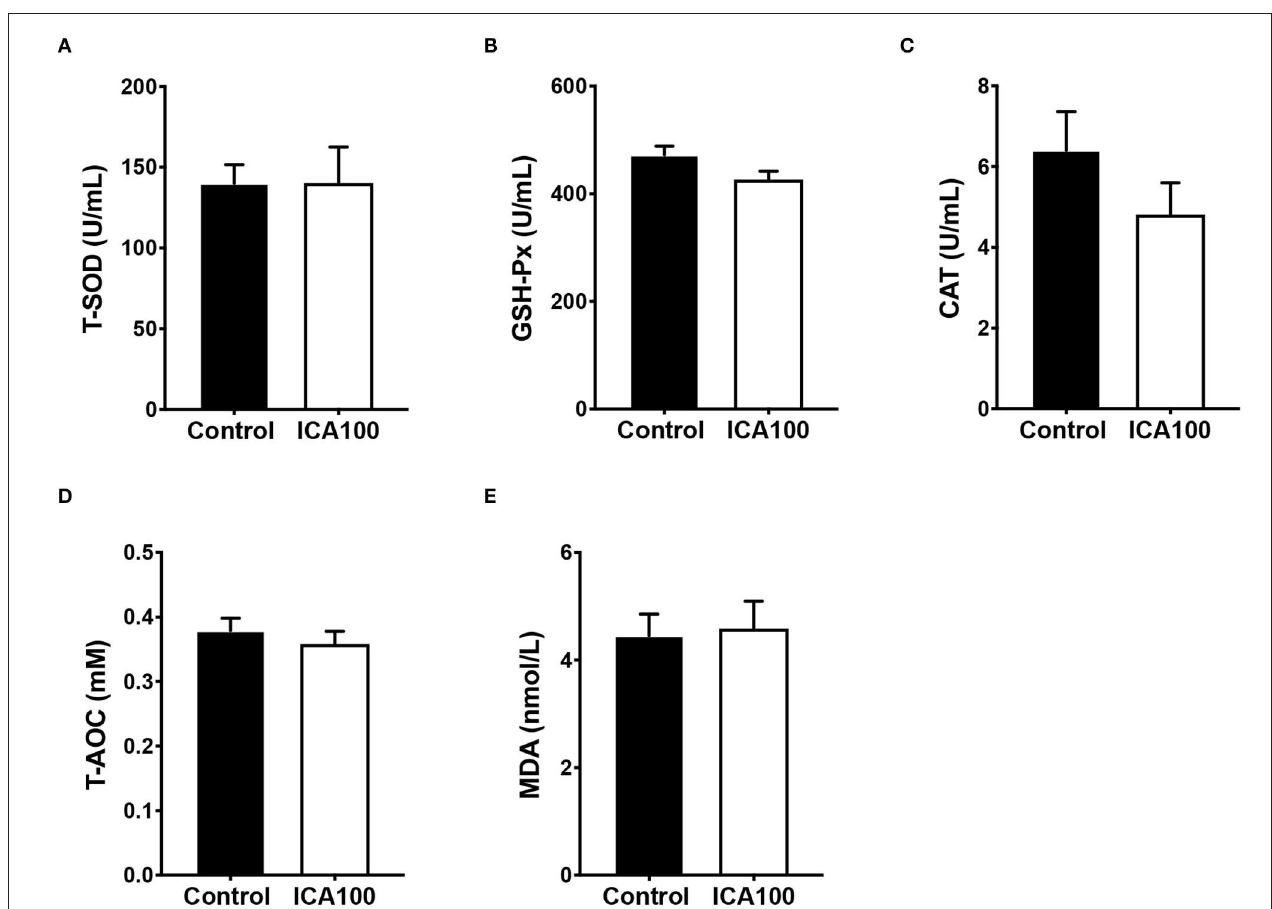
FIGURE 4 | Effects of dietary ICA supplementation on the activities of T-SOD (A) , GSH-Px (B) , and CAT (C) , and the contents of T-AOC (D) , and MDA (E) in serum of weaned piglets. Data are expressed as mean ± SEM. ICA100, the basal diet supplemented with 100 mg/kg indole-3-carboxaldehyde. T-SOD, total superoxide dismutase; GSH-Px, glutathione peroxidase; CAT, catalase; T-AOC, total antioxidant capacity; MDA,